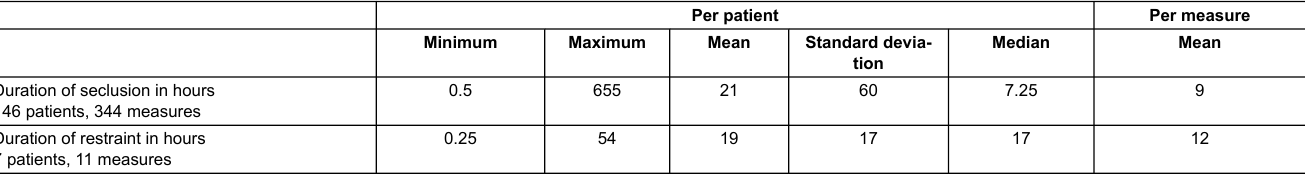
Table 2: Duration of coercive measures during a 6 month